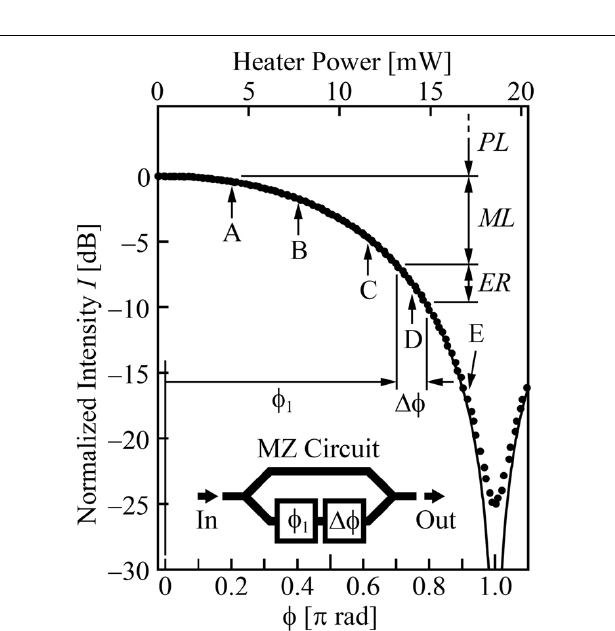
FIGURE 1 | Intensity response (solid line) and measured ones (closed circles) as a function of the phase shift of the MZ modulator and corresponding heater power in phase tuner. The intensity is normalized by that at φ 1 = 0.